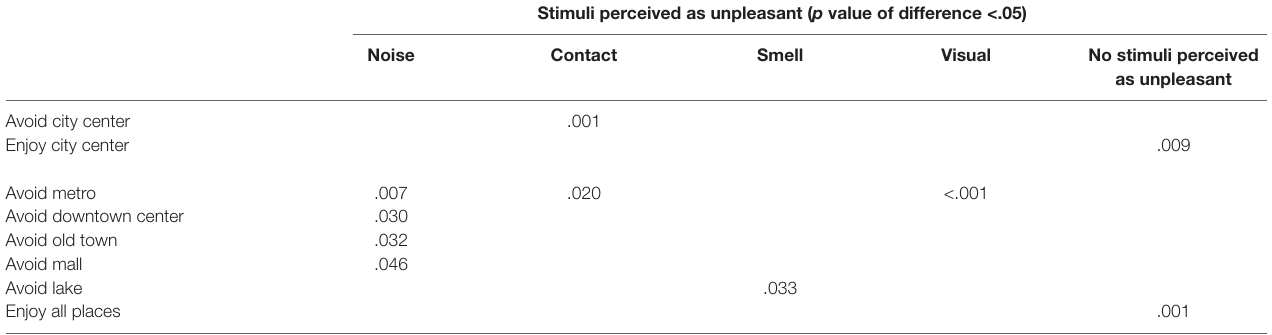
TABLE 4 | Correlation between stimuli perceived as unpleasant and likelihood to avoid certain urban places. Stimuli perceived as unpleasant ( p value of difference